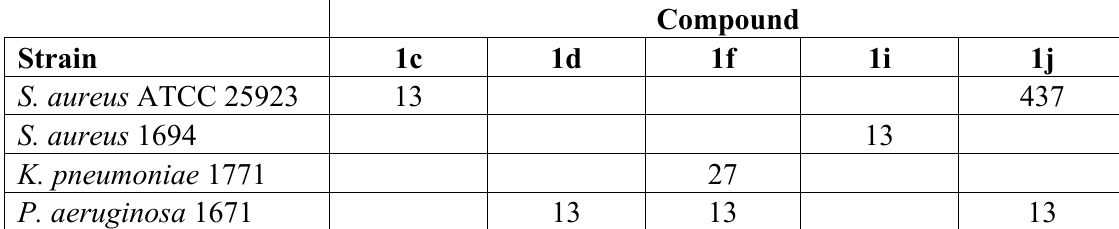
Table 3. Results of the quantitative assay of the influence of the tested compounds on the adherence ability and biofilm development on the inert substratum (values of inhibitory concentrations of biofilm development are expressed in μ